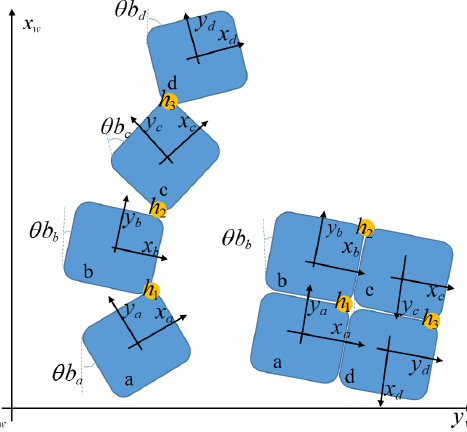
Figure 3. hTetro platform location on workspace and shifting mechanism to O shape.